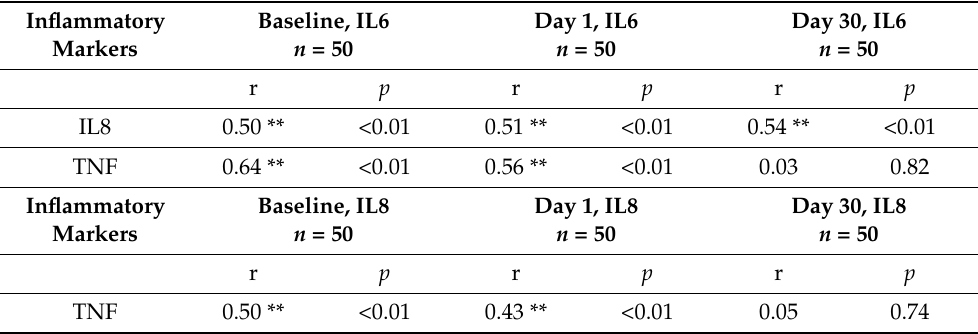
Table 2. Spearman correlation coefficients (r) between inflammatory markers.